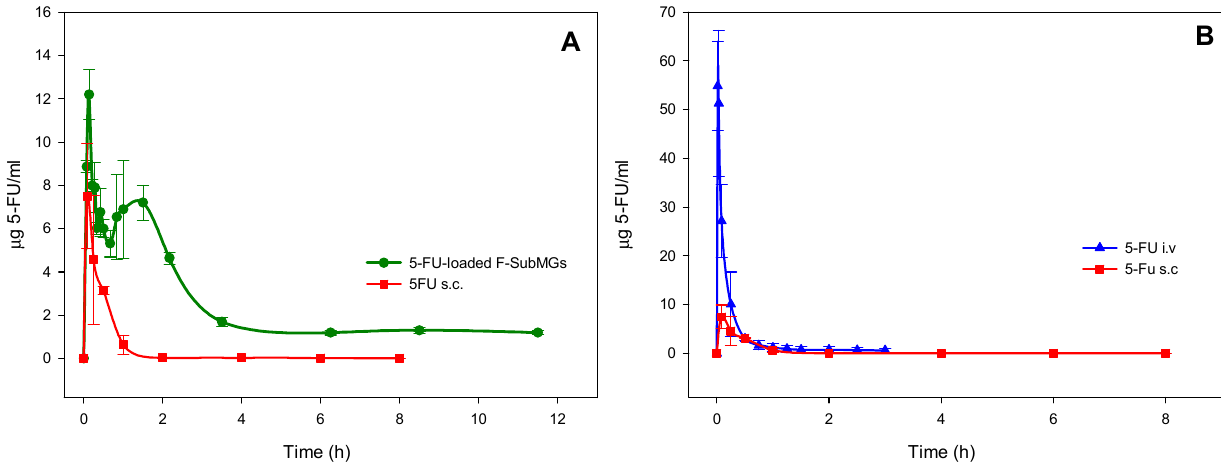
Figure 6. Plasma concentration of 5-fluorouracil (5-FU) after: ( A ) subcutaneous injection of 5-FU-loaded folate-conjugate submicrogels and subcutaneous (s.c.) injection of 5-FU; ( B ) subcutaneous and intravenous injection of an aqueous solution of 5-FU; Drug dose: 28 mg 5-FU/kg